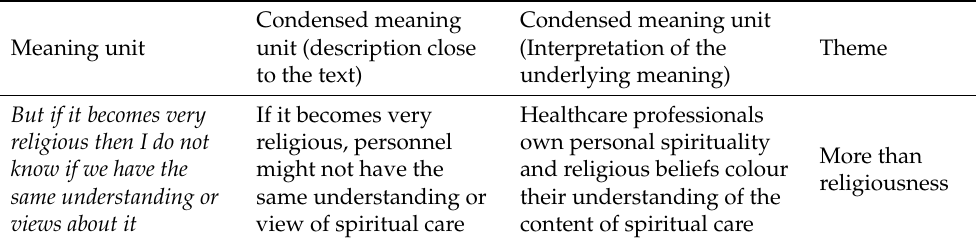
Table 3. Example of a meaning unit, condensed meaning units and